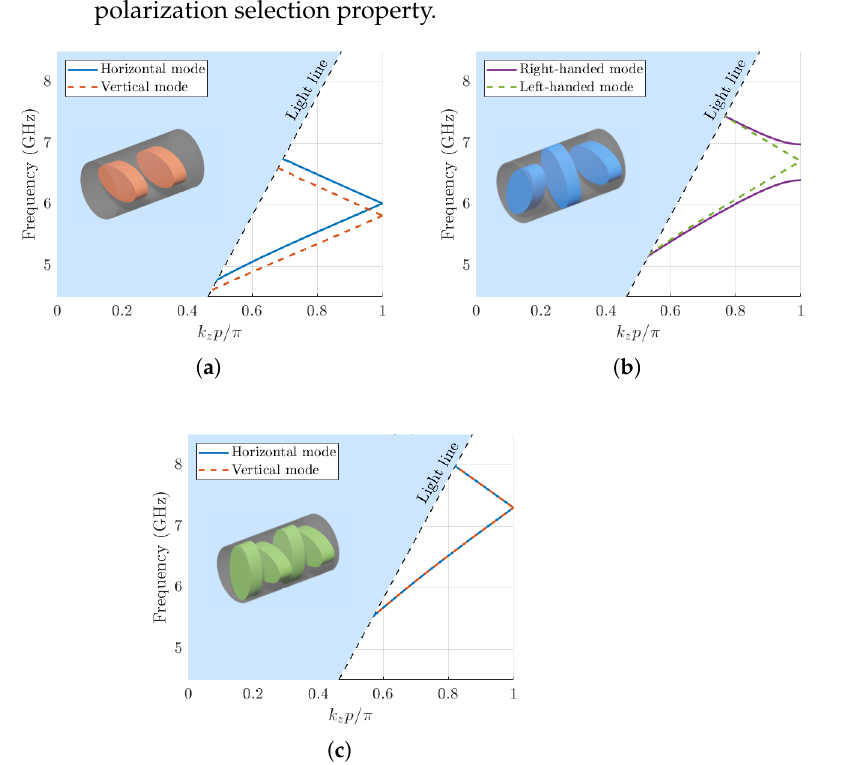
Figure 2. Dispersion diagram of a dielectric rod with ( a ) 2, ( b ) 3 and ( c ) 4 folds with parameters p = 15.4mm, w = 3.85mm, r 1 = 7mm, r 2 = 4.2mm, (cid:101) 1 = 10 and (cid:101) 2 = 3.